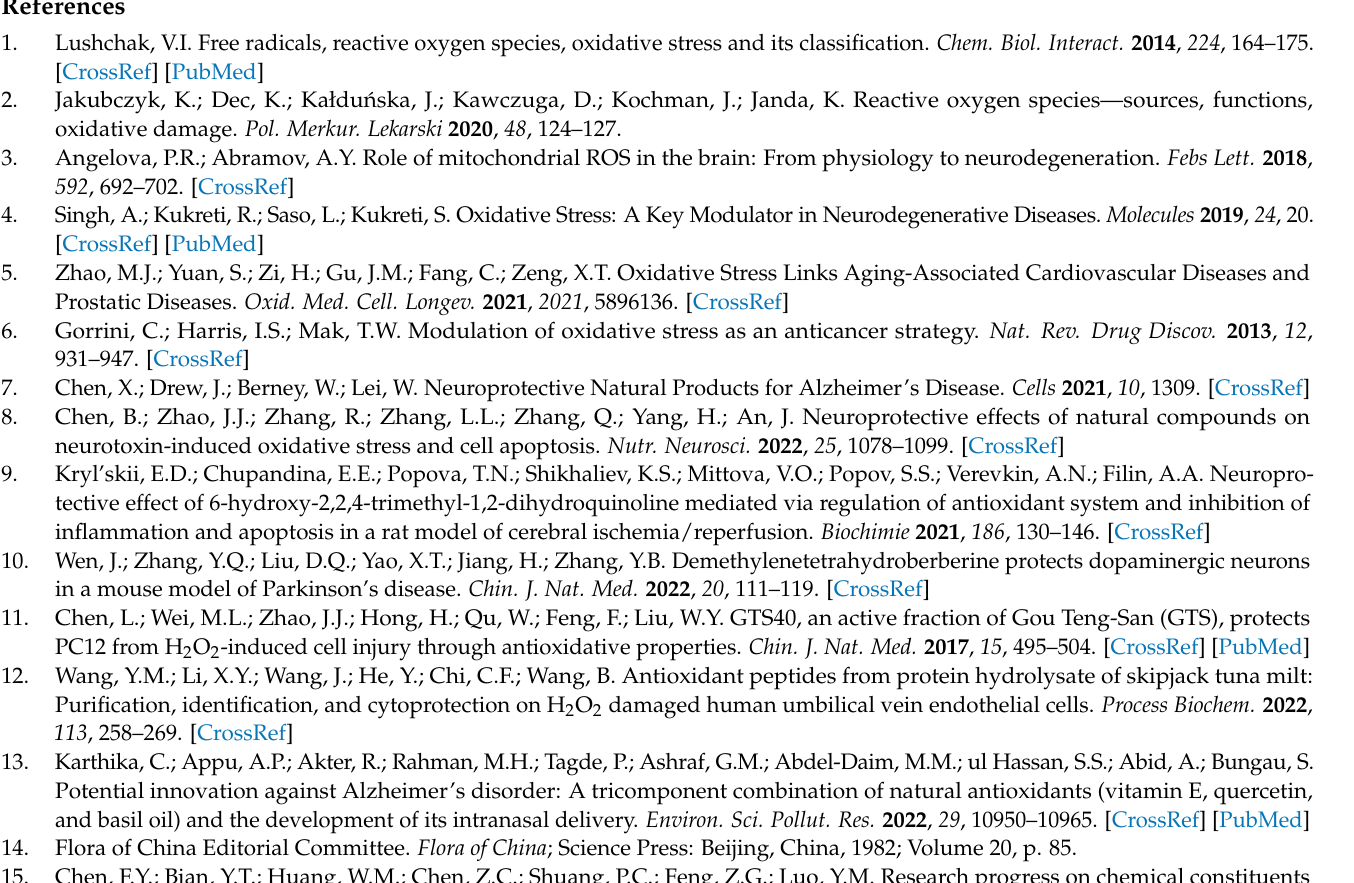
HSQC spectrum of compound 1 , Figure S6: HMBC spectrum of compound 1 , Figure S7: NOESY spectrum of compound 1 , Figure S8: HRESIMS of compound 1 , S9: The method of NO production, Figure S9: Dose-effect curve of compound 1 on LPS-induced NO